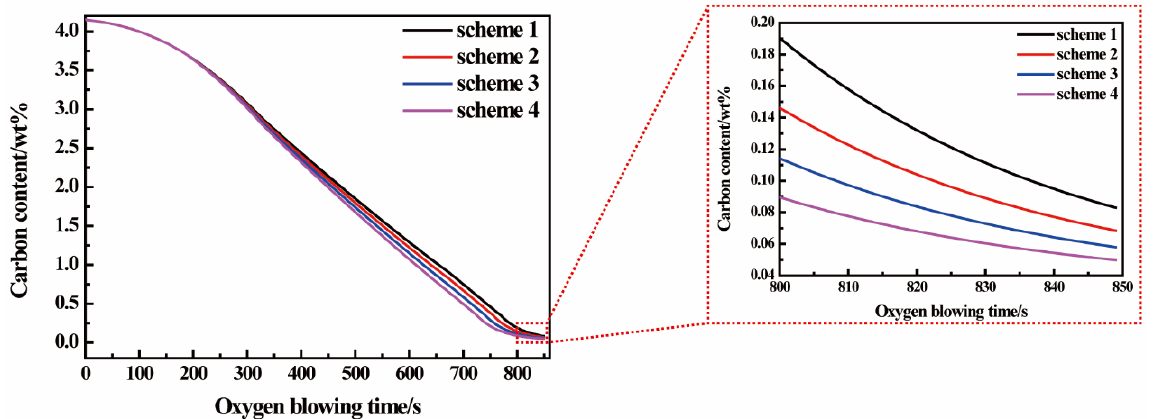
Figure 9. The influence of main blowing oxygen lance height on decarburization process.